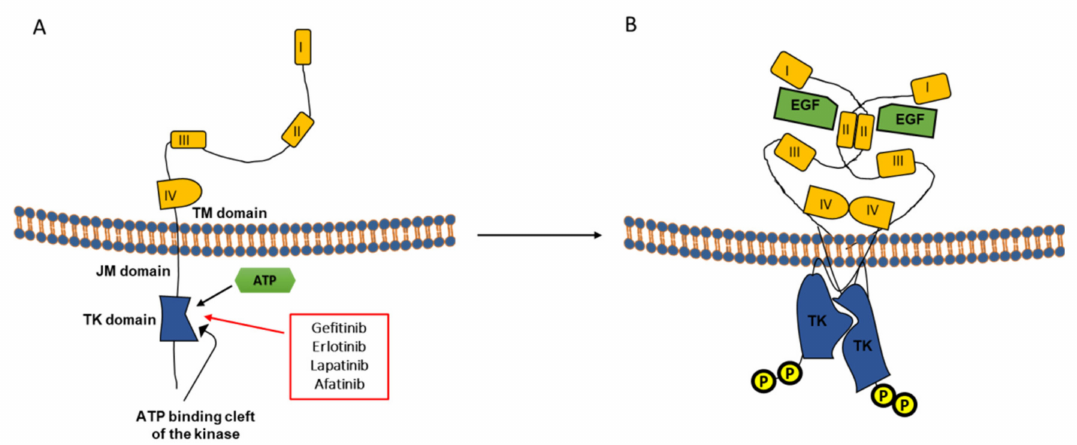
Figure 2. EGFR structure and activation. ( A ) ECD of EGFR consists of four subdomains noted, respectively, I, II, III, and IV, followed by a transmembrane domain (TM), juxtamembrane domain (JM), and tyrosine kinase domain (TK). ( B ) Ligand binds to domains I and III simultaneously, and mediates physical interaction between receptors. This favor intracellular conformational changes and kinase activation by allosteric mechanism. EGFR inhibitors are ATP competitor and act by binding the ATP binding